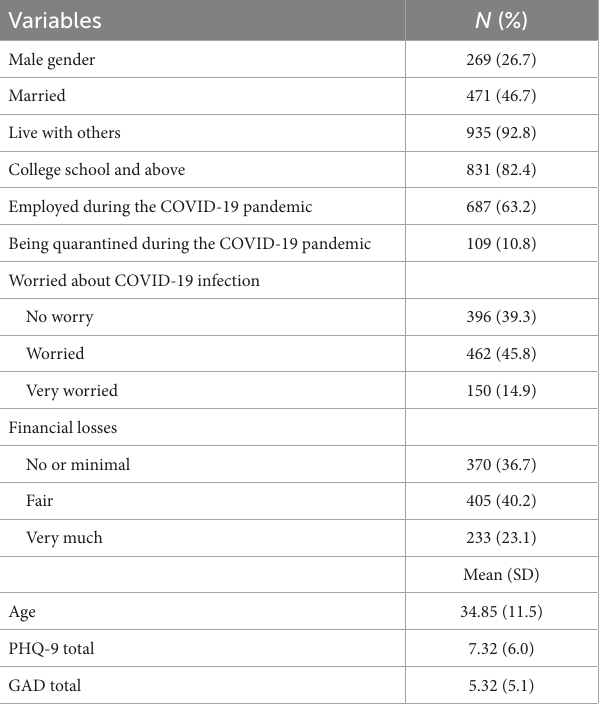
TABLE 1 Socio-demographic and clinical information of Macau residents ( n = 1,008).